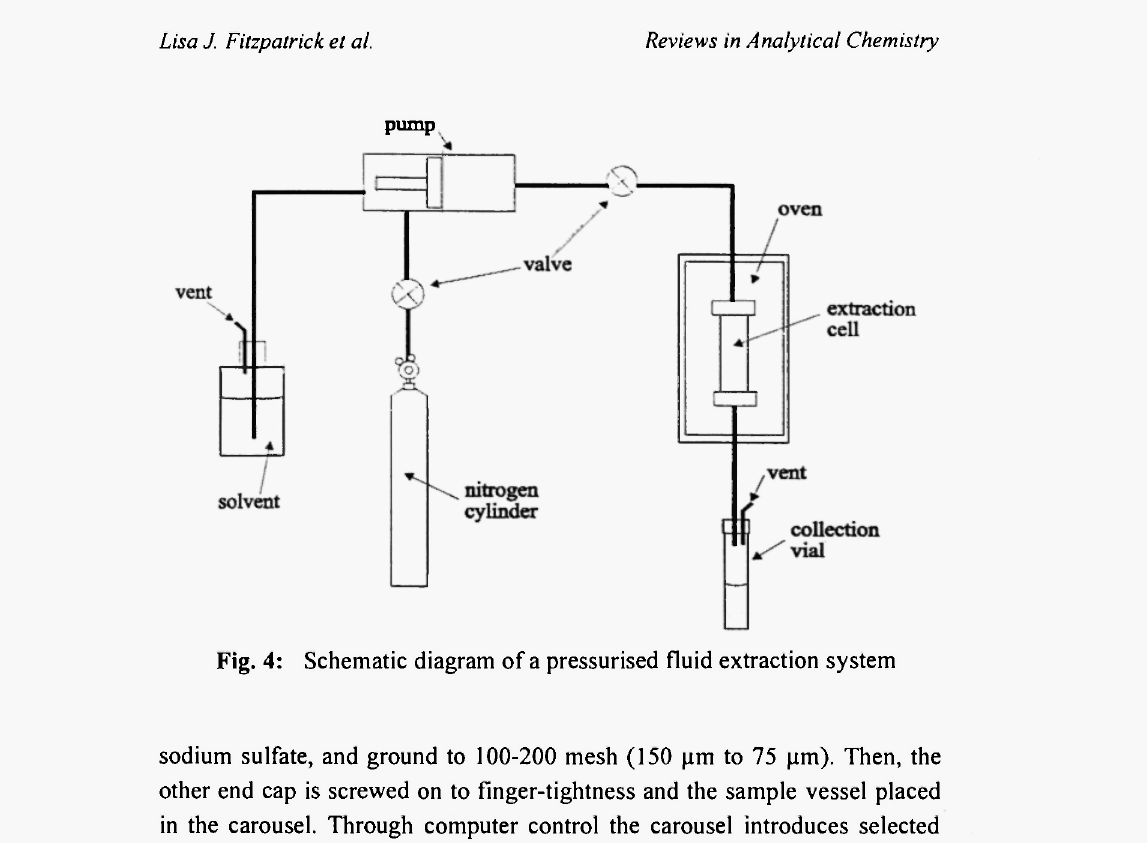
Fig. 4: Schematic diagram of a pressurised fluid extraction